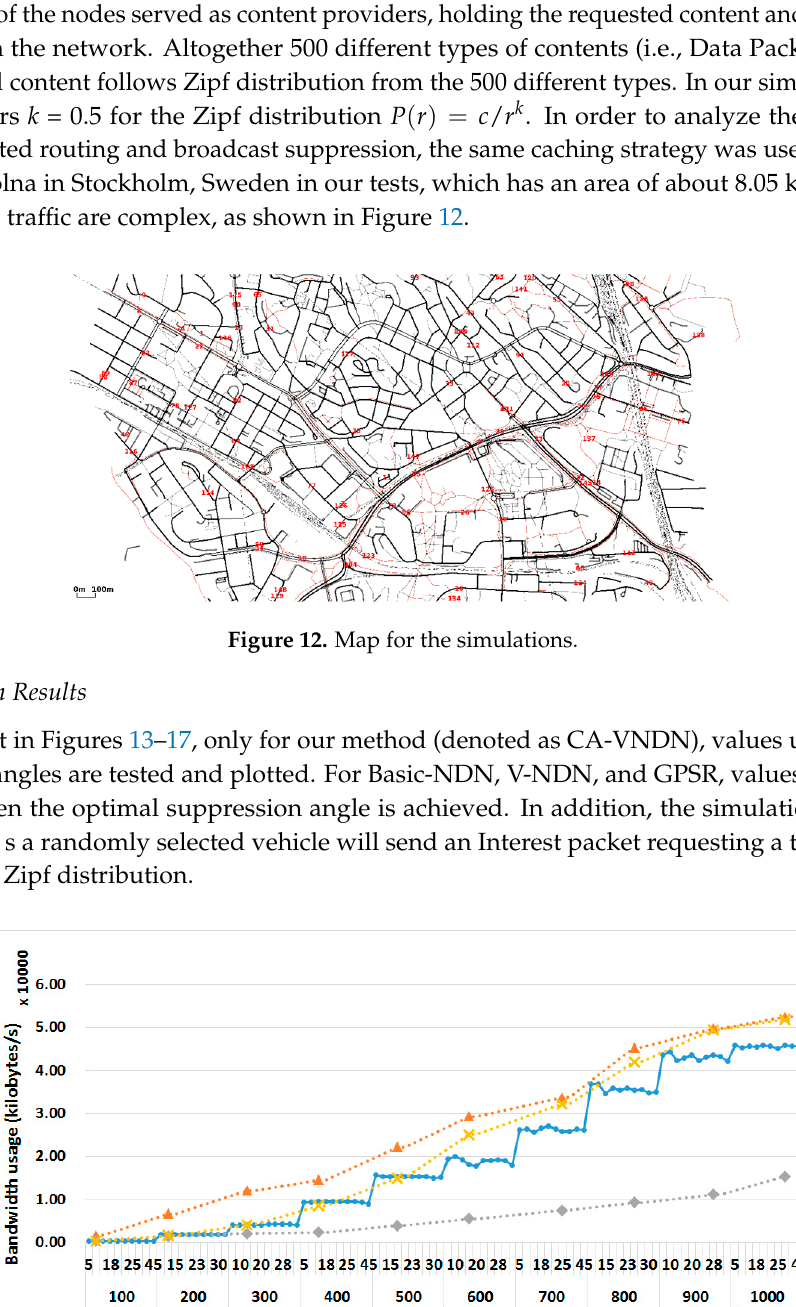
Figure 1 2 . Map for the simulations.